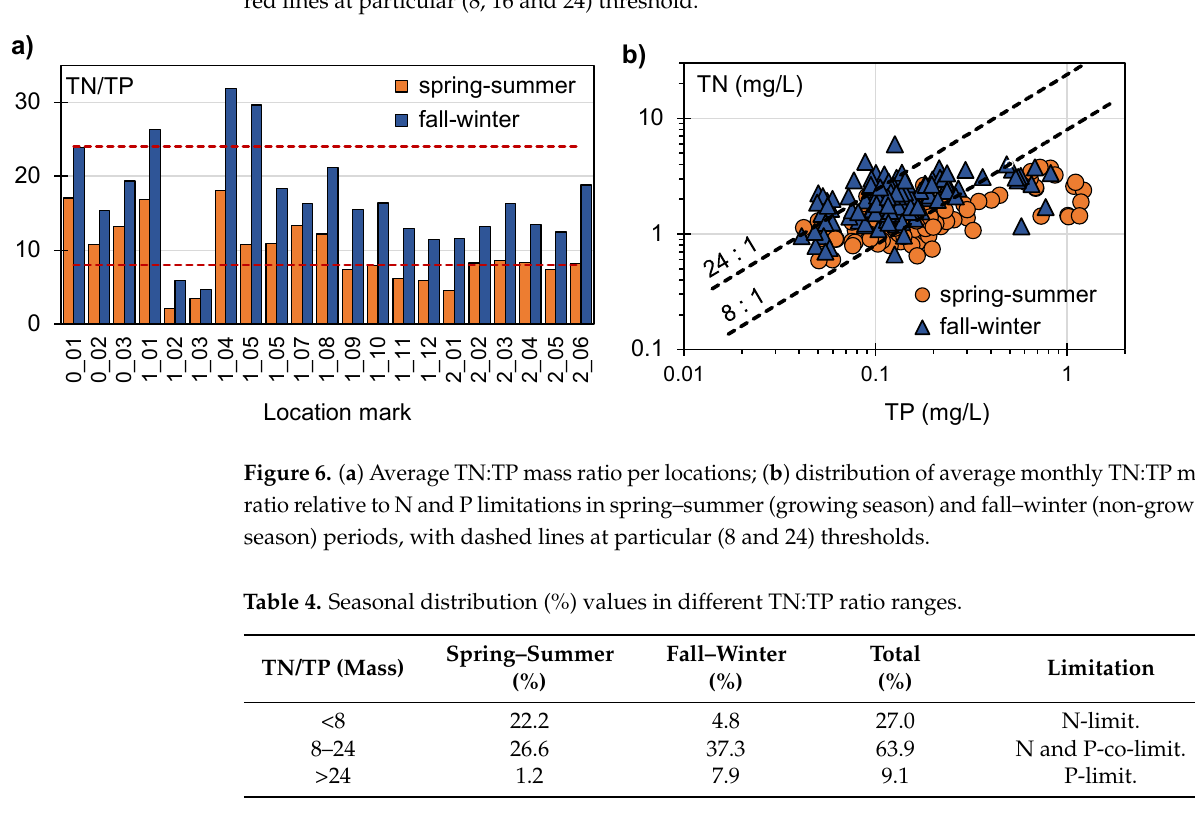
Table 5. Pearson correlation matrix.